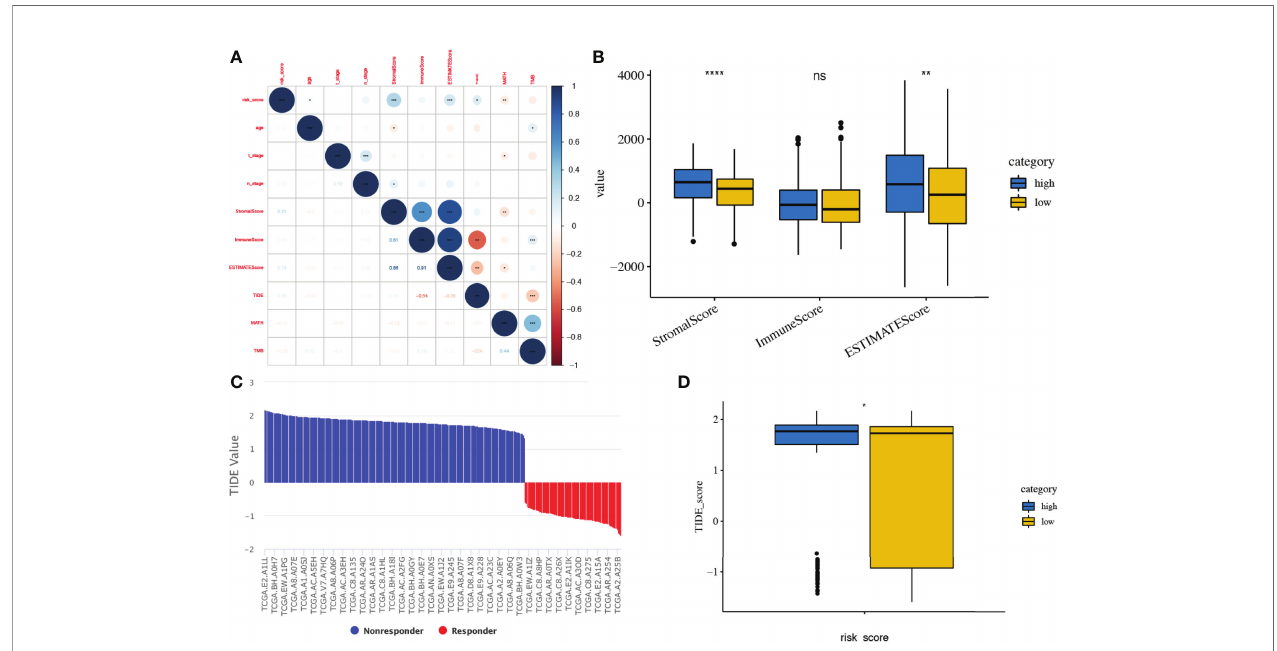
FIGURE 9 | Tumour microenvironment and immunotherapy prediction. (A, B) Association of risk score and tumour microenvironment. (C, D) TIDE scores in different risk score subgroups. TIDE, Tumour Immune Dysfunction and Exclusion. *, **, ***, **** and expanded form of "ns" denote p<0.05, p<0.01, p<0.001, p<0.0001, and p ≥ 0.05,